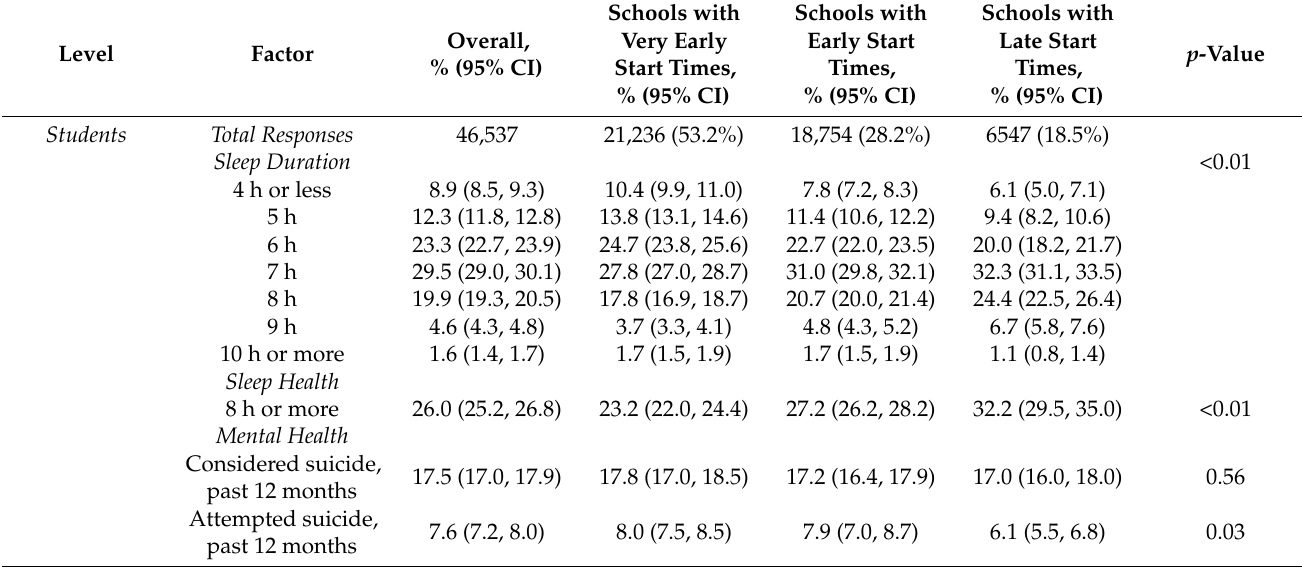
Table 2. Prevalence of sleep and mental health outcomes by school start time.